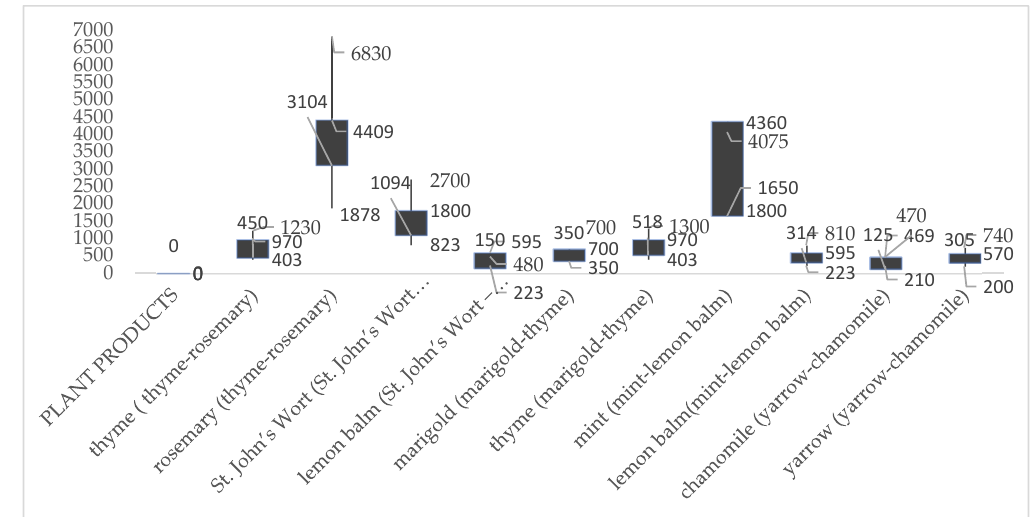
Figure 16. Graphic representation of vegetable products mass in 2021. Table 4. Representation of vegetable products’ mass in 2021.